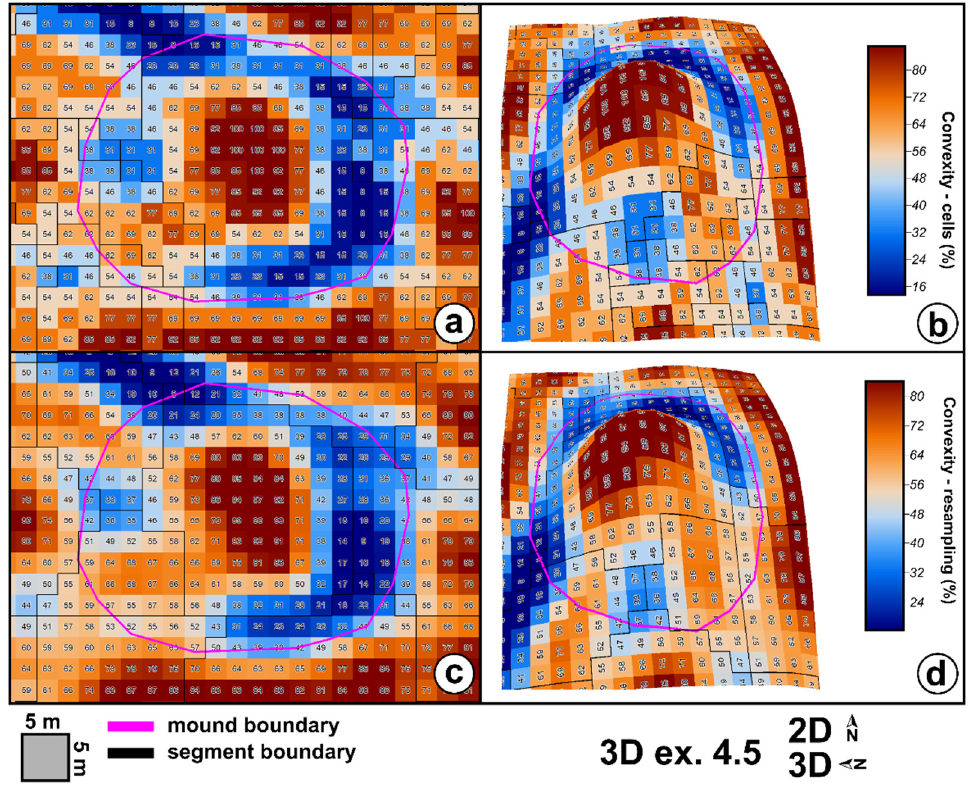
Figure 19. The burial mound watershed delineation based on both methods of local convexity computation: ( a ) (2D) and ( b ) (3D) for cell count method, and ( c ) (2D) and ( d ) (3D) for the cell count interpolation method. (a high-resolution version can be found at https://doi.org/10.6084/m9.figshare.11798700.v1).